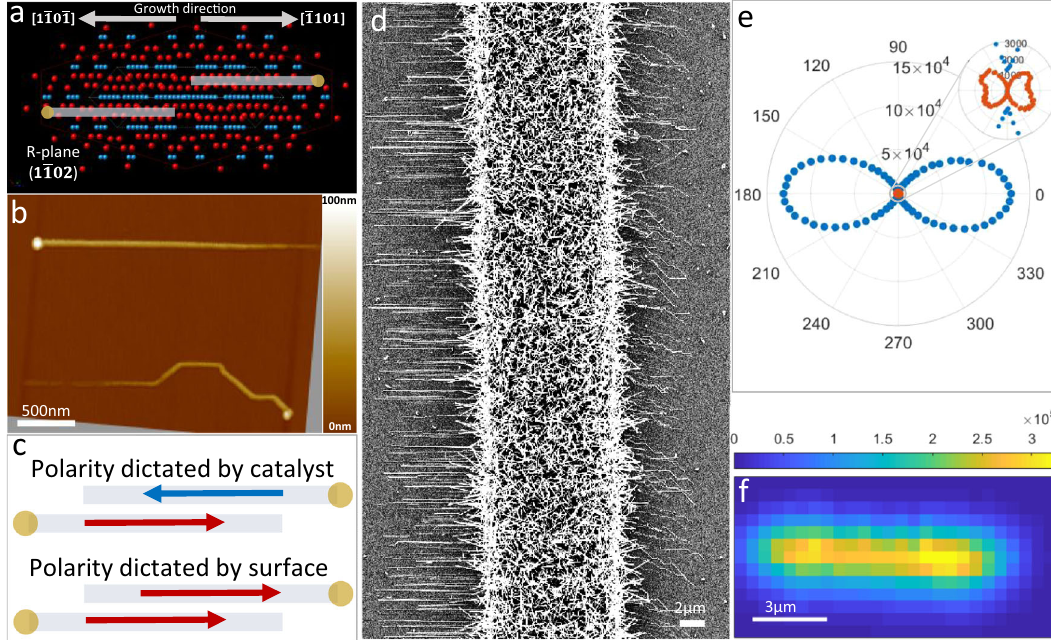
Fig. 1 Surface-guided ZnO nanowires on R-plane sapphire: epitaxy, SHG mapping and polarimetry. a Crystallographic model of R (1 (cid:1) 102) plane sapphire showing clear atomic rows of Al and O along ±[1 (cid:1) 10 (cid:1) 1] that give rise to the nanowires ’ alignment in these directions. The two cartoons depict the two possible growth directions of nanowires. b AFM image of two nanowires growing in two opposite directions on R-plane sapphire from gold nanoparticles, presenting the different morphologies between the two possible growth directions (straight to the left and kinked to the right). c Scheme describing the two possible outcomes. 1. Catalyst droplet dictates polarity so that nanowires with opposite growth directions have the same polarity and 2. Substrate dictates polarity so that nanowires with opposite growth directions have opposite polarities (the red and blue arrows denote polarity to the right and left, respectively, and the yellow circles represent the catalyst droplet (the growing tip of the nanowire). d SEM image of ZnO nanowires growing in two opposite directions on R-plane sapphire from evaporated gold catalyst. In one direction the nanowires are perfectly aligned while in the other they tend to lose directionality. e Typical SHG polarimetry of a polar nanowire along either the [1 (cid:1) 10 (cid:1) 1] or the [ (cid:1) 1101] direction of the sapphire, depicting the excitation polarization dependence of the SHG signal. The radial coordinate is the signal intensity (in counts per second) and the angle is the excitation polarization angle in the lab frame. Inset is a magni fi cation of the centre of the plot. f SHG mapping at a fi xed polarization (signal colour scale in arbitrary units). Note that all plates ( a – f ) are shown in the same orientation with respect to the [1 (cid:1) 10 (cid:1) 1] and [ (cid:1) 1101] directions of the